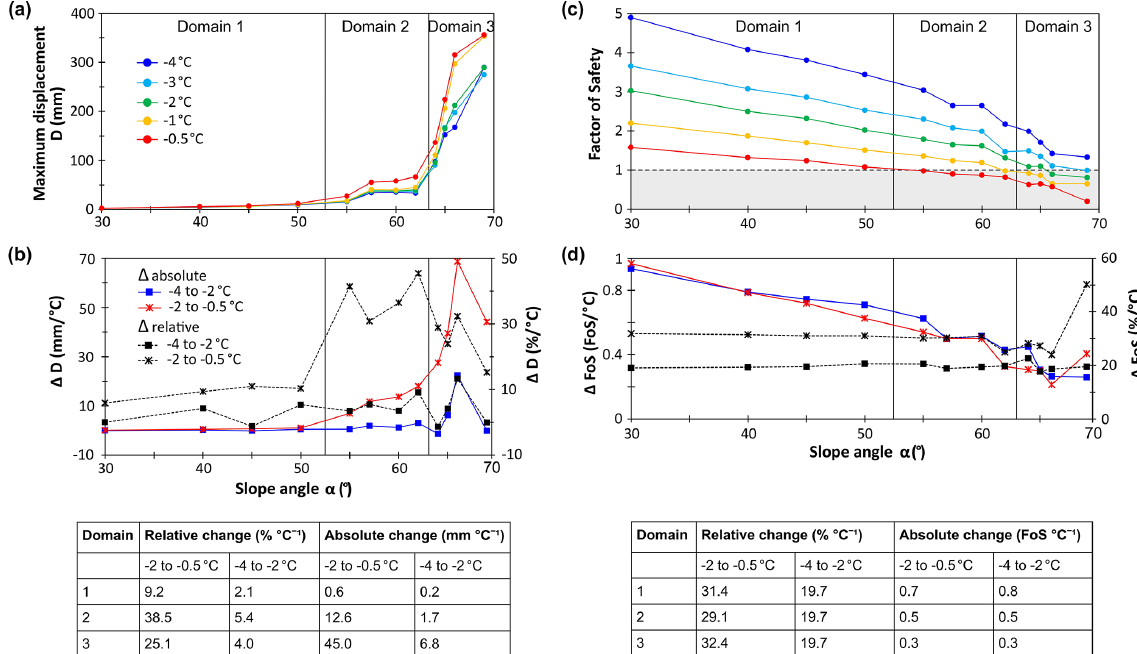
Figure 8. The above figure provides critical slope angles and rock temperatures beyond which instability is introduced. (a) Calculated maximum displacements against slope angle for temperatures between − 4 and − 0 . 5 ◦ C. The curves are assigned to three distinct domains depending on the slope gradient, with domain divisions above 50 ◦ and above 62 ◦ respectively, where the curves point to a sudden onset of instability. (b) Absolute and relative increase in displacements versus slope angle for a warming from − 4 to − 2 ◦ C and from − 2 to − 0 . 5 ◦ C. (c) Calculated factor of safety (FS) against slope angle for different sub-zero temperatures. (d) Absolute and relative decrease in FS versus slope angle for a warming from − 4 to − 2 ◦ C and from − 2 to − 0 . 5 ◦ C.